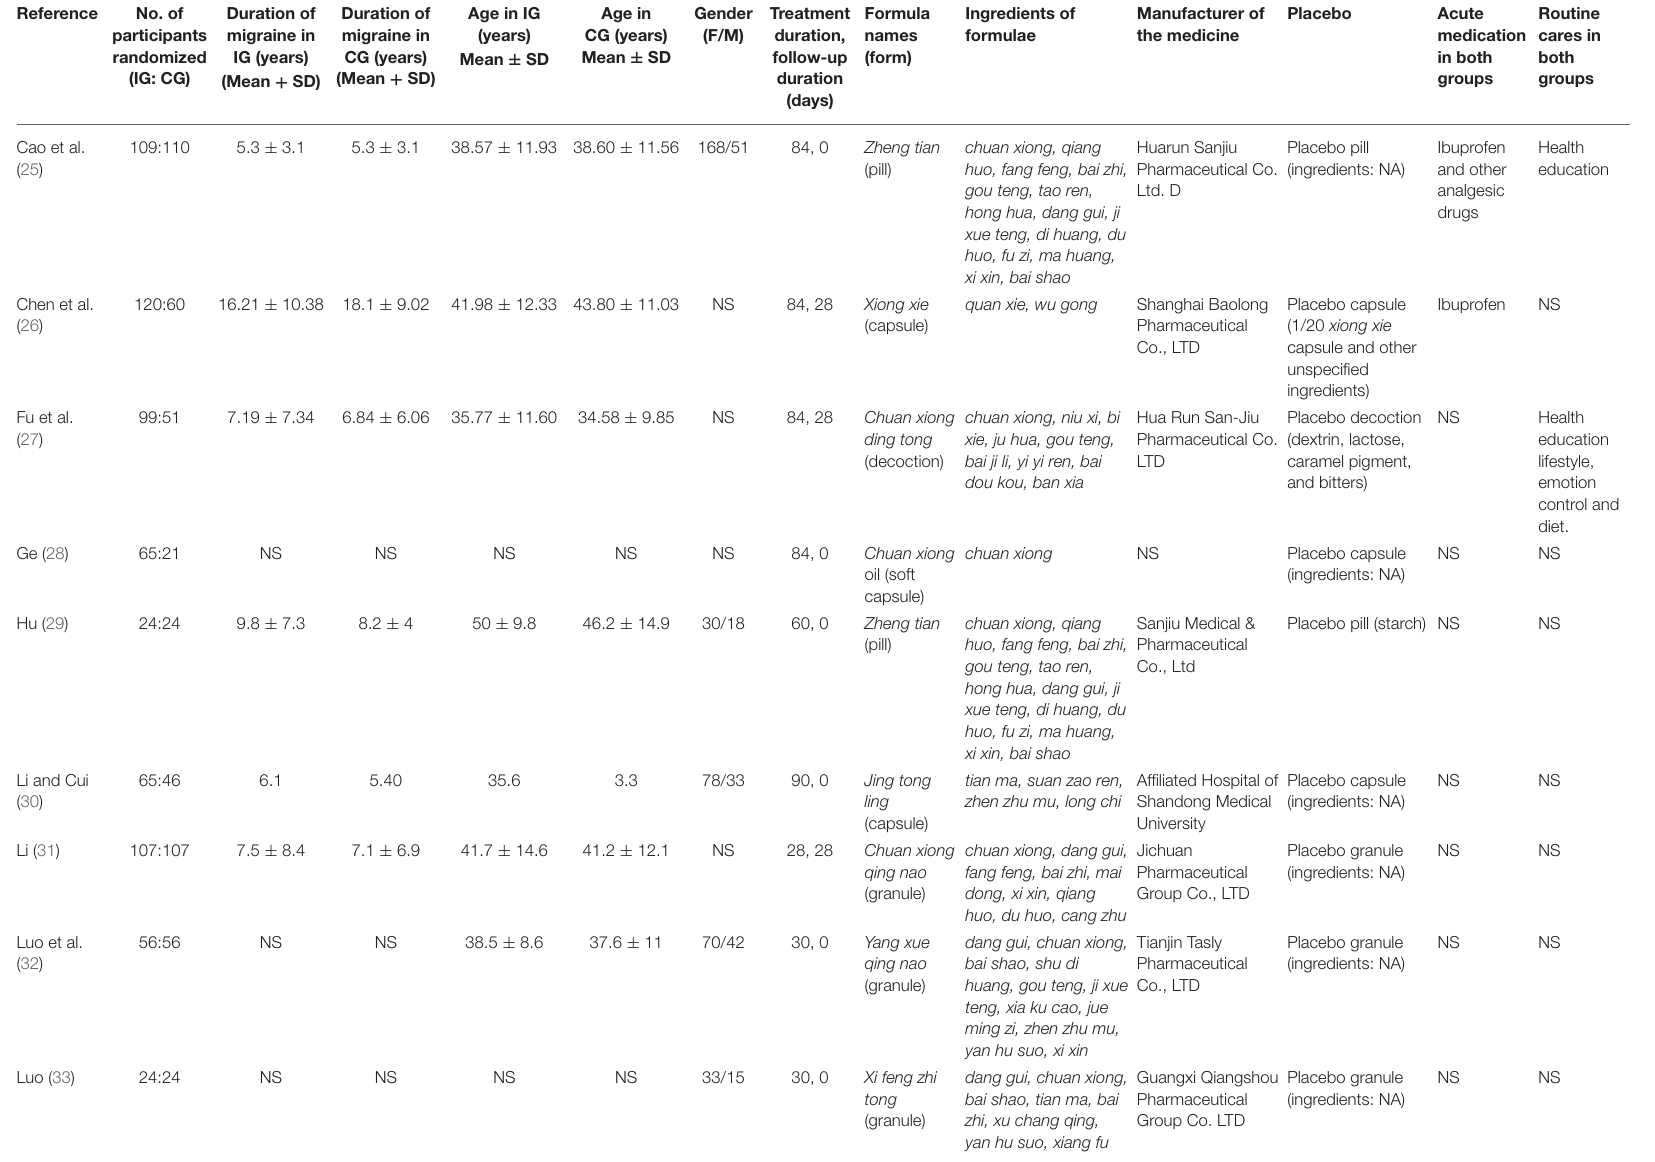
TABLE 1 | Characteristics of included studies.